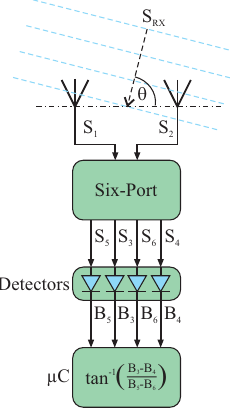
Figure 11. Six-port system for interferometric angle of arrival